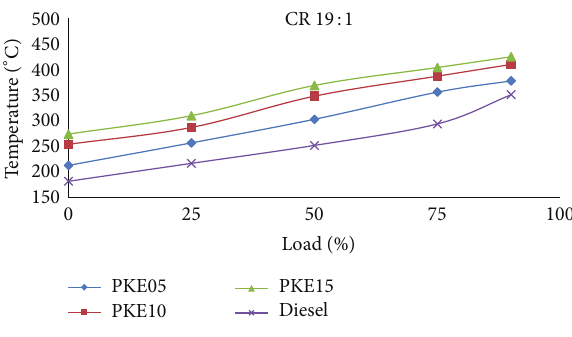
Figure 9: Load versus exhaust gas temperature at 19: 1 CR.